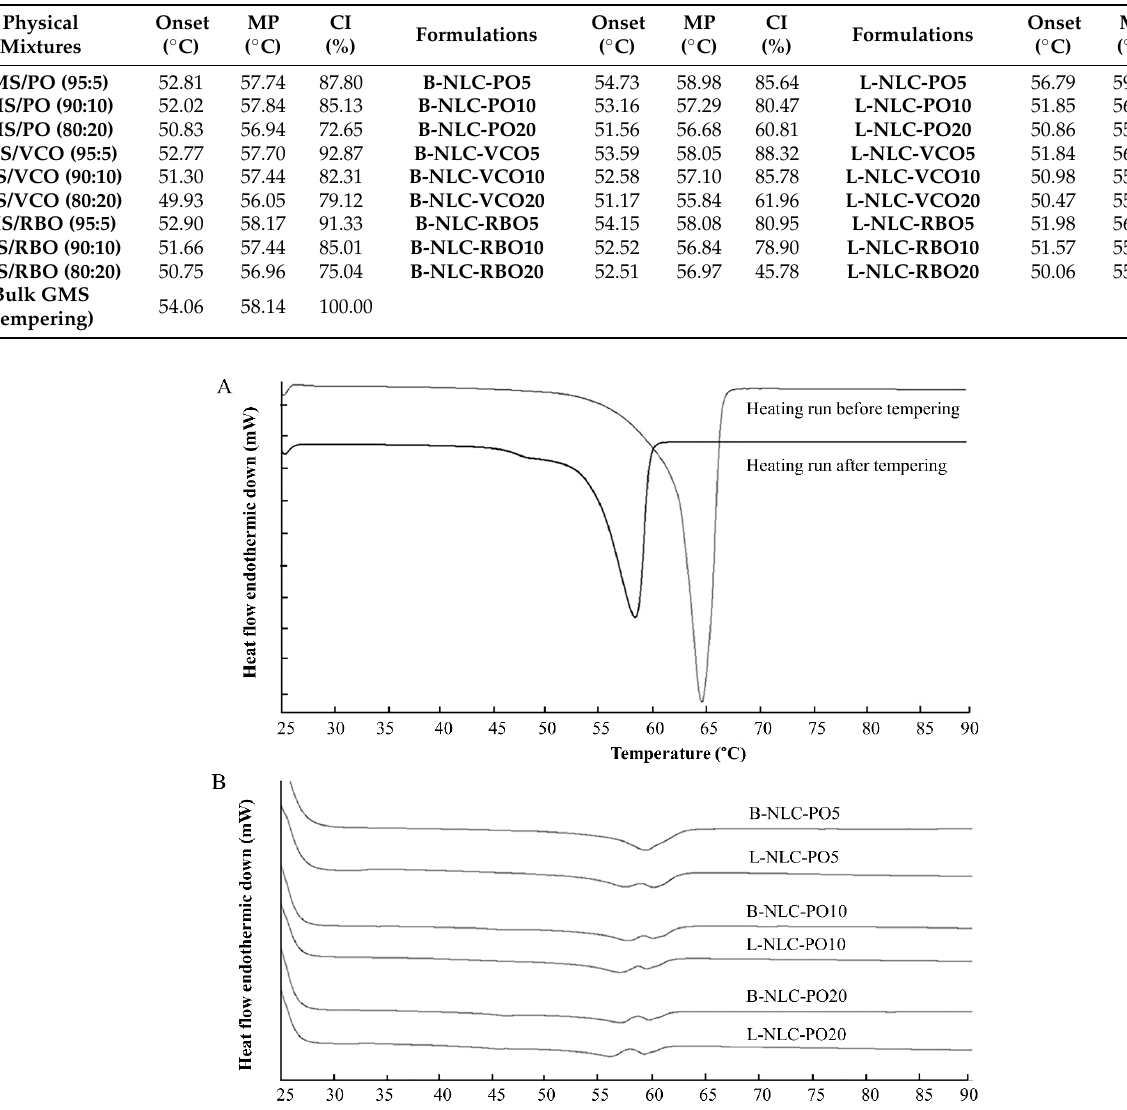
Table 3. The onset, melting endotherm and %CI of physical mixtures of GMS and vegetable oils at different ratios, lutein-free and lutein-load nanocarriers, and bulk GMS after tempering.